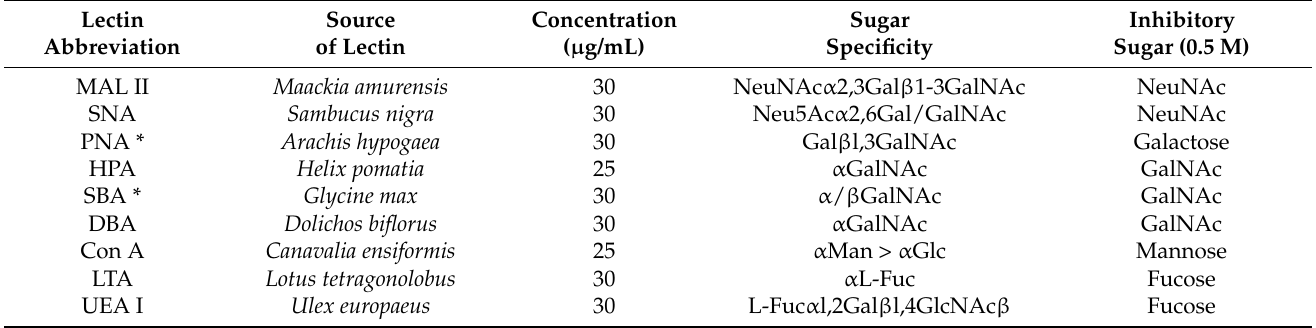
Table 1. Lectin used, their sugar specificities, and the inhibitory sugars used in control